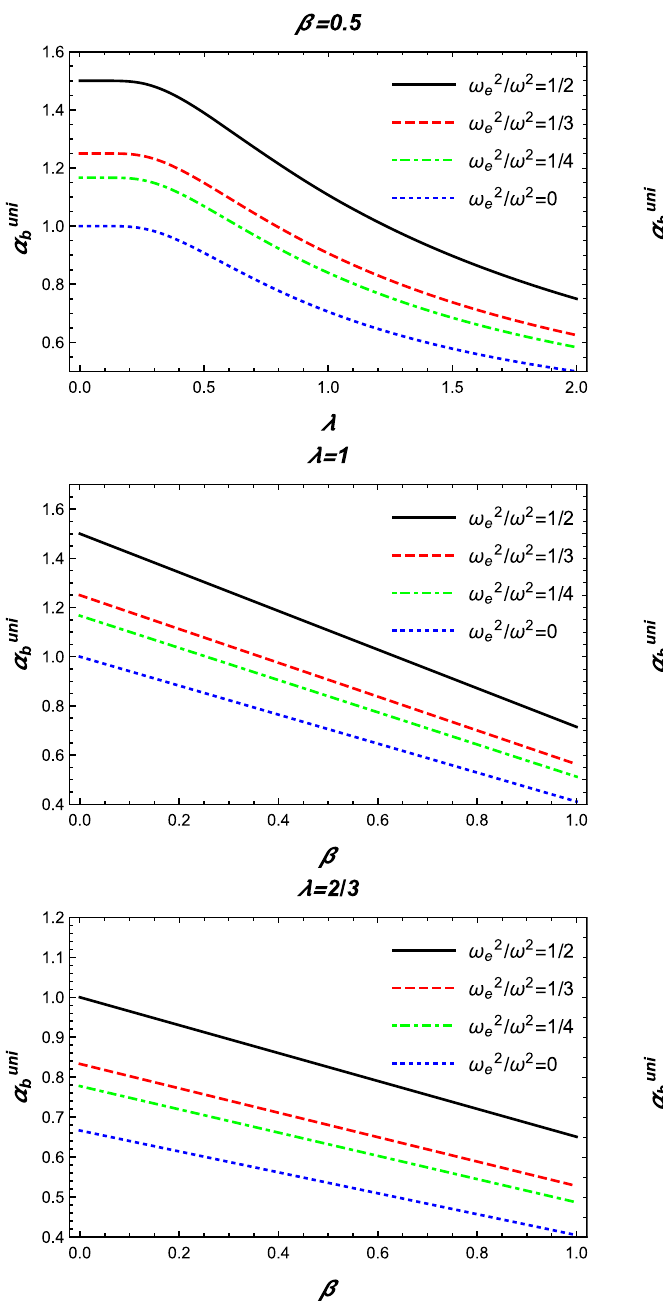
Fig. 12 α b for different value ω 2 e /ω 2 , β and λ in the uniform plasma Fig. 13 α